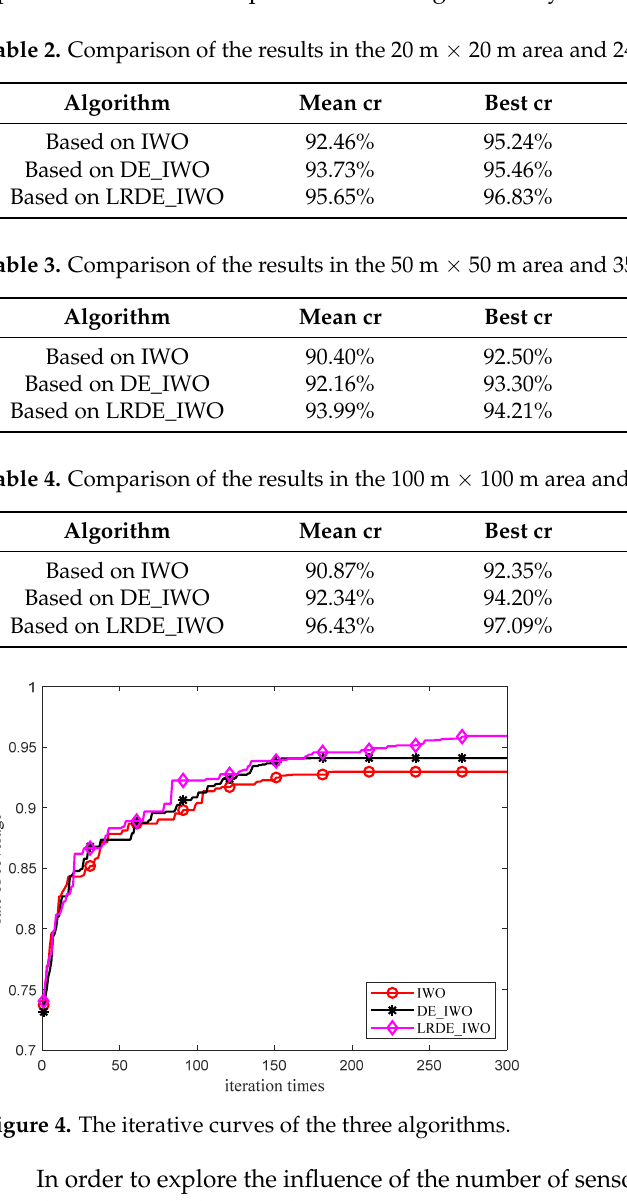
Table 3. Comparison of the results in the 50 m × 50 m area and 35 nodes.